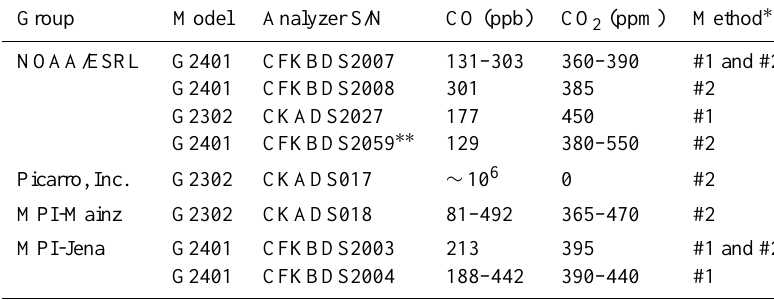
Table 1. Summary of water tests for CO on a series of Picarro CRDS